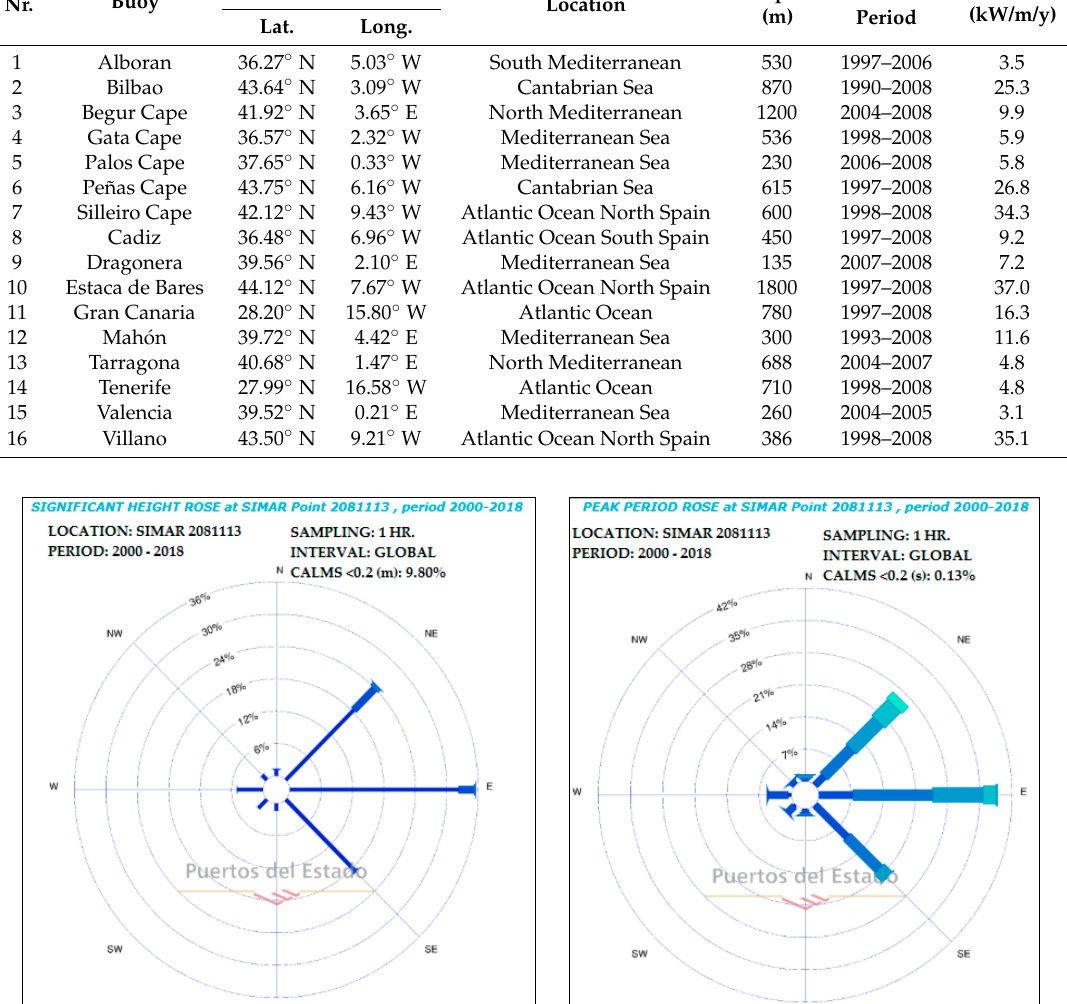
Table 6. Annual average wave power along the Spanish coast (REDEXT). Source: www.puertos.es. Nr.